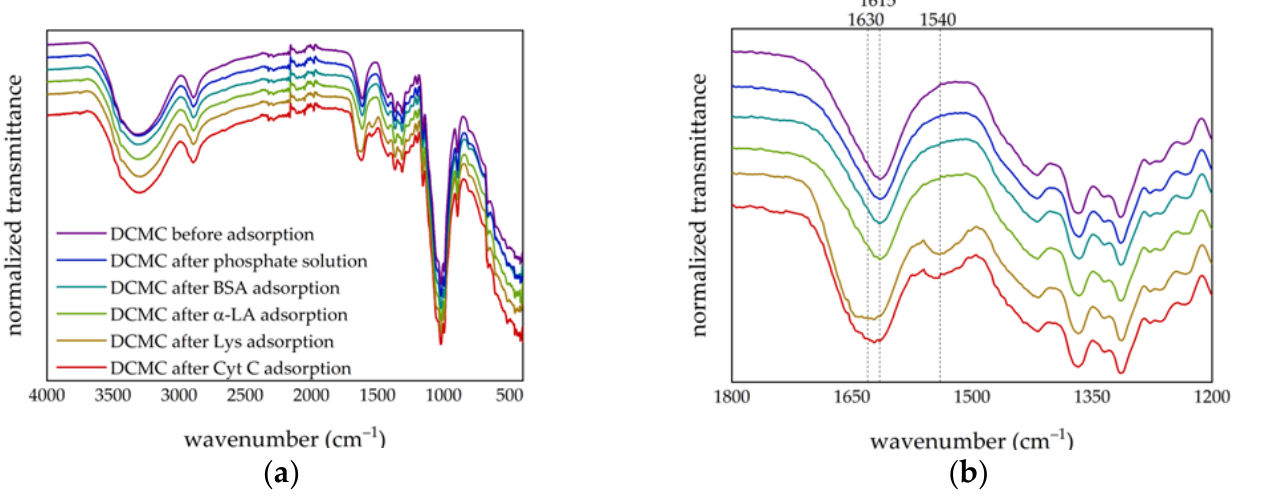
Figure 10. FTIR spectra of ( a ) DCMC before and after adsorption of the solutions (buffer and proteins) and ( b ) zoom of the region between 1200 and 1800 cm − 1 .